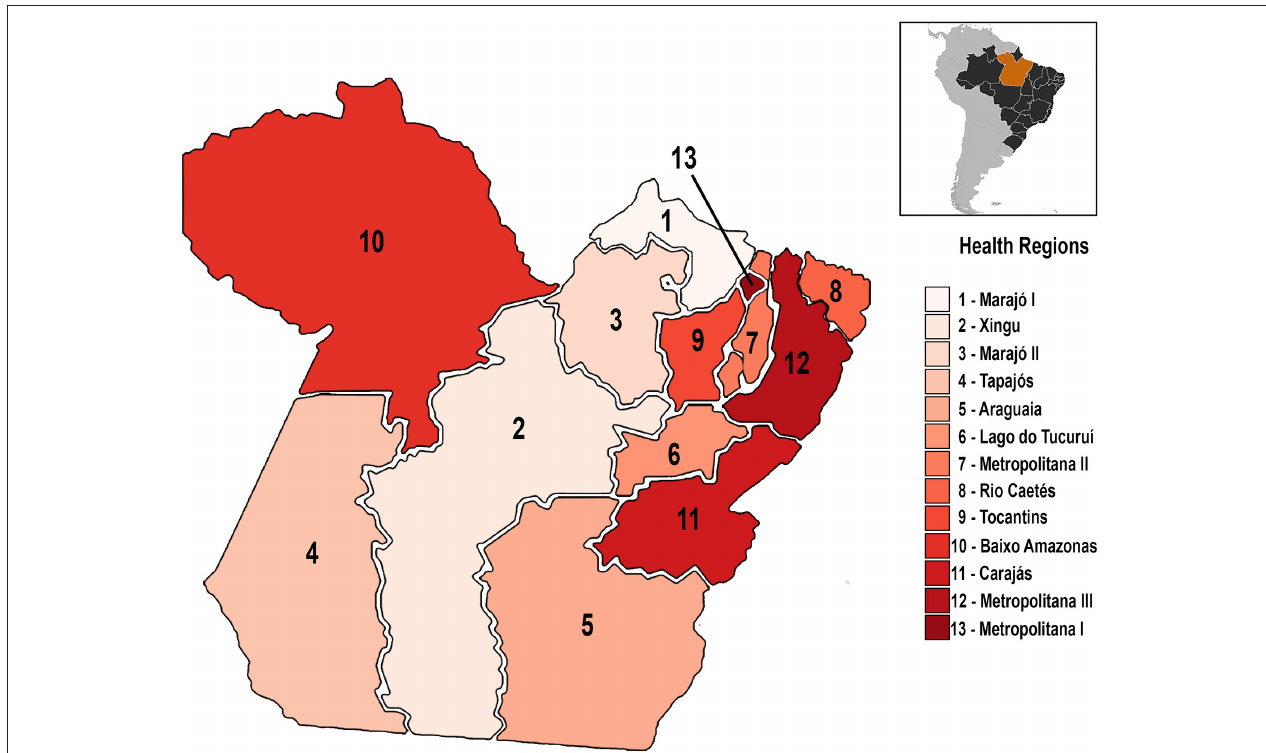
FIGURE 2 | Pará’s administrative division (SESPA). The regionalization of care resources is a national effort to reduce health inequities among Brazil’s regions. In the Pará state, there are 13 health regions, which comprise the 144 municipalities of the area, considering their geographical